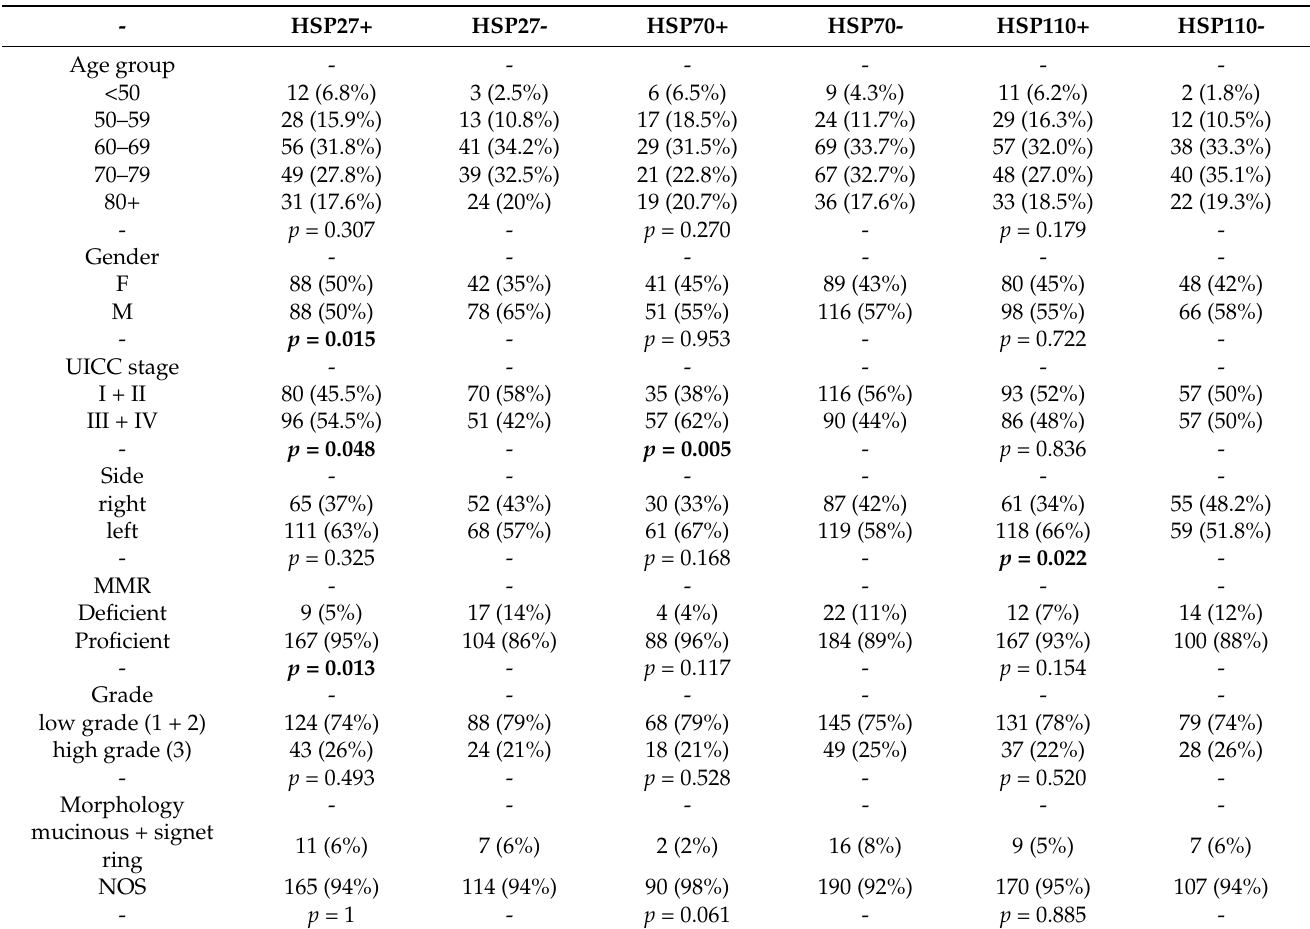
Table 1. Summary of Pearson’s chi-squared test showing numbers of colorectal carcinomas (CRCs) expressing particular types of heat shock protein (HSP) in relation to traditional clinical-pathological variables. Significant p values (<0.05) are